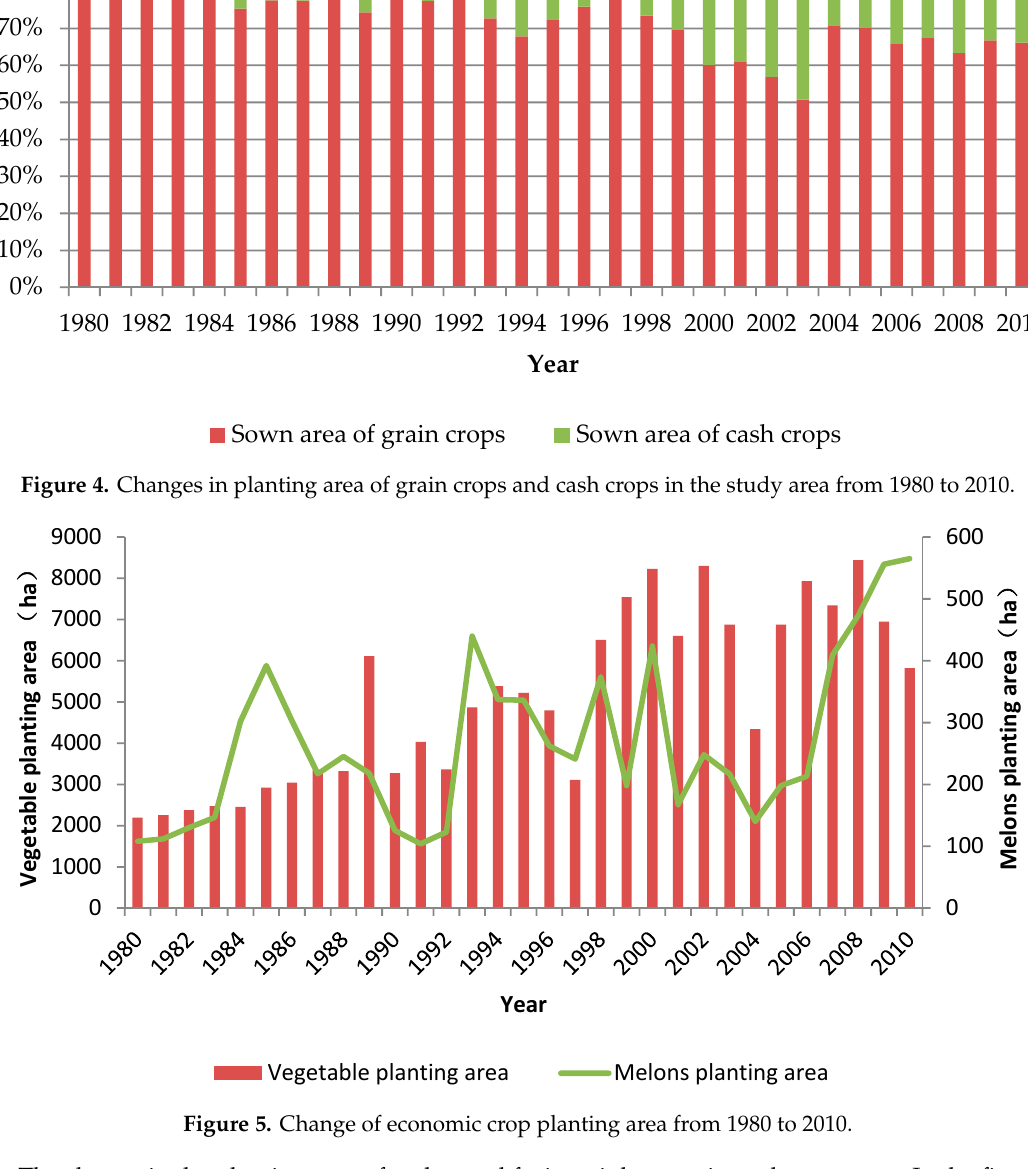
Figure 4. Changes in planting area of grain crops and cash crops in the study area from 1980 to 2010.